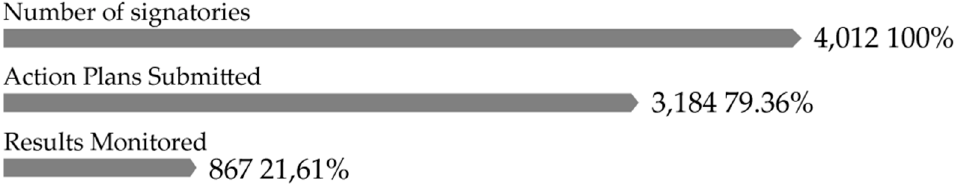
Figure 1. Overview of CoM signatories and SEAP submitted in Italy.